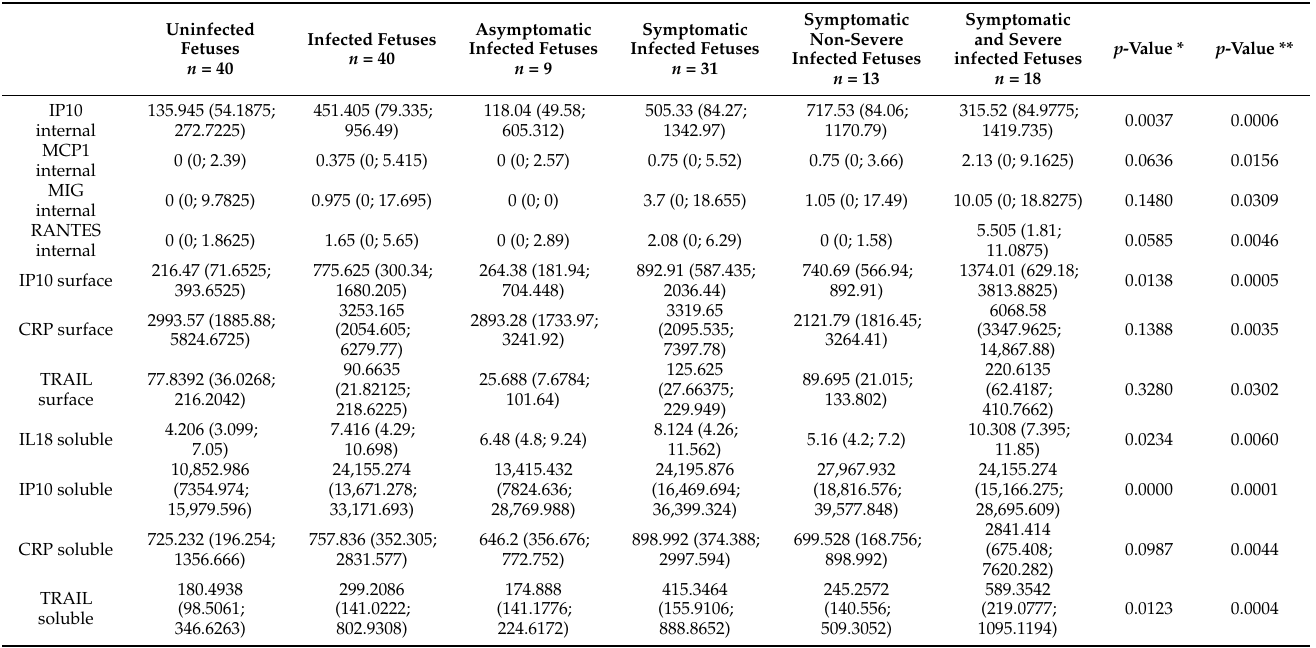
Table 3. Concentrations of relevant cytokines in amniotic fluid according to symptomatic status at birth and severity (median and